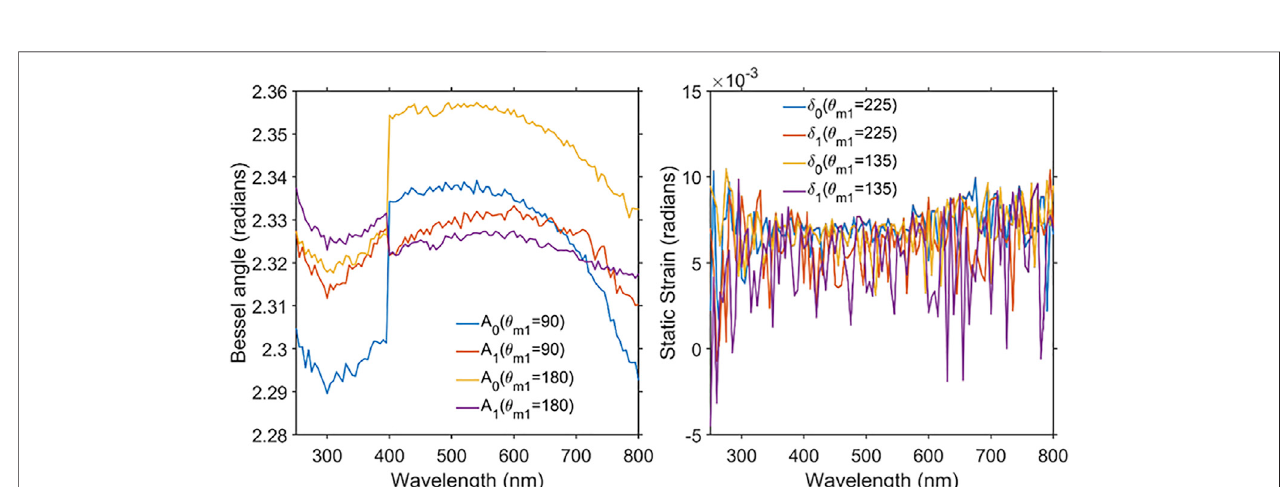
FIGURE3| TypicalBesselamplitudes A 0 , A 1 andstaticstrains δ 0 , δ 1 asafunctionofwavelength.WenotethattheBesselamplitudesareinthedesired rangefrom 2.28 to 2.38. A jump is seen around the wavelength of 400 nm, where the monochromator grating and PEM calibration function is changed.